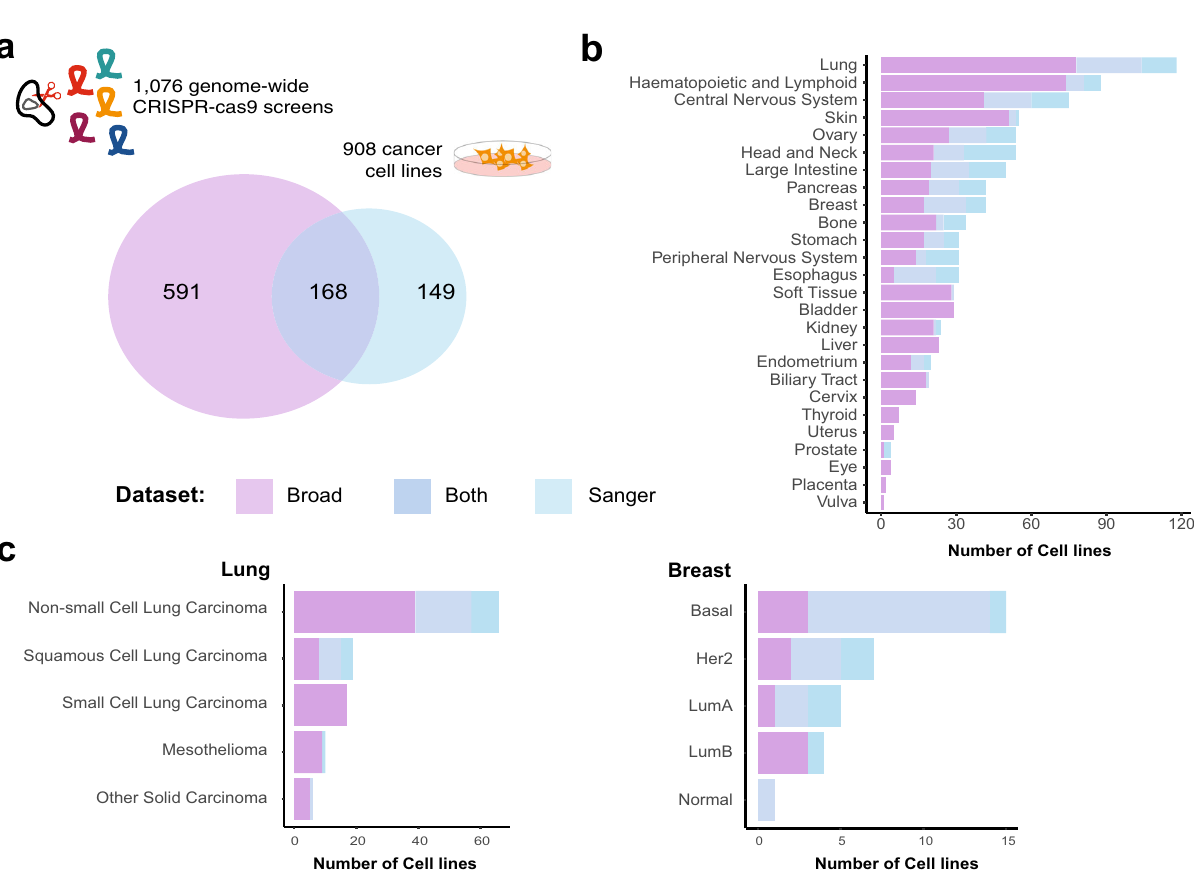
Fig. 2 Overview of CRISPR-Cas9 screened cancer cell lines. a Number of cell lines screened by the Broad and the Sanger institutes and their overlap. b Overview of the number of cell lines screened for each tissue type across the two datasets. c Number of screened lung cancer and breast cancer cell lines split according to cancer types and clinical PAM50 subtypes, respectively, across the two